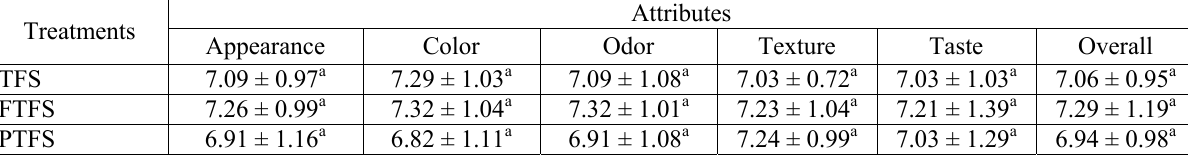
Table 7. Sensory acceptability score of fortified Vietnamese tamarind fish sauce before and after pasteurization